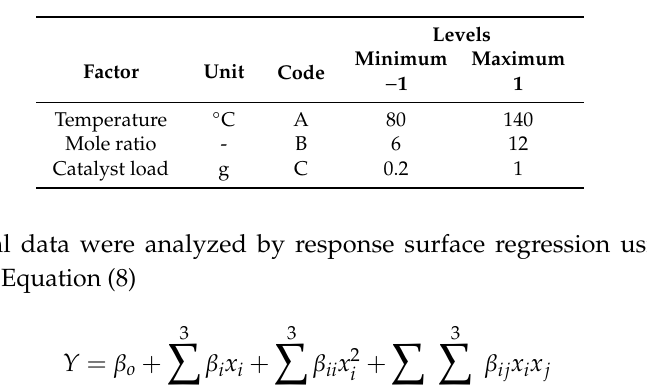
Table 5. Independent variables (factors) with their codes and